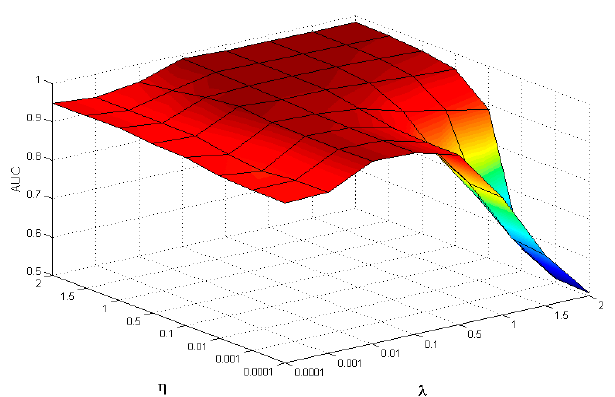
ff erent parameters for AVIRIS_Salinas dataset. Table 1. Results with different parameters for the AVIRIS_Salinas data. Figure 4. Results with different parameters for AVIRIS_Salinas dataset. Figure 4. Results with di